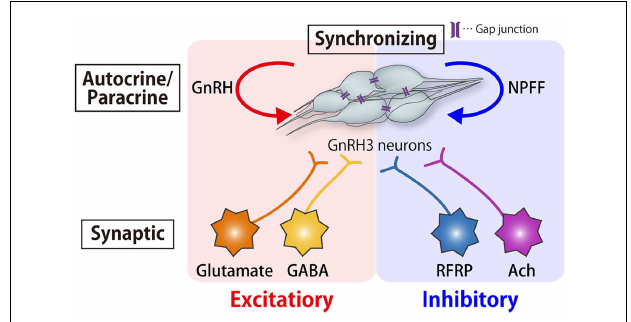
FIGURE 7 | Schematic drawing of the autocrine/paracrine, synchronizing, and synaptic mechanisms for the modulation of pacemaker frequency of theTN-GnRH3 neurons .The tight cluster of TN-GnRH3 neurons release both GnRH and NPFF peptides, which function as autocrine/paracrine positive and negative feedback modulators, respectively.There is also a synchronizing mechanism for the pacemaker firings via gap junctions. In addition, there are excitatory (glutamatergic and GABAergic) and inhibitory (RFRPergic and AChergic) synaptic mechanisms for modulation of pacemaker